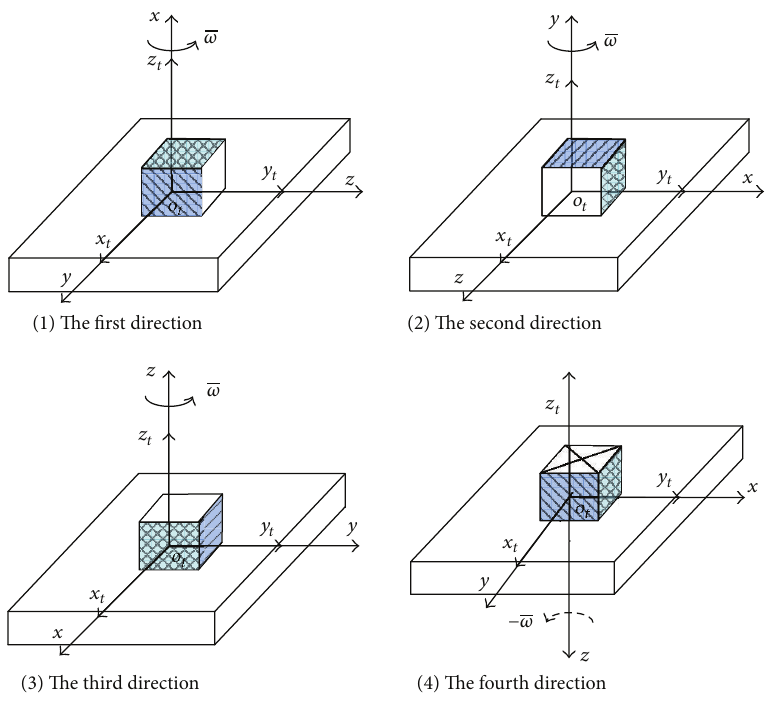
Figure 1: An optimization four-direction rotation rate calibration method using a single-axis turntable with temperature control.